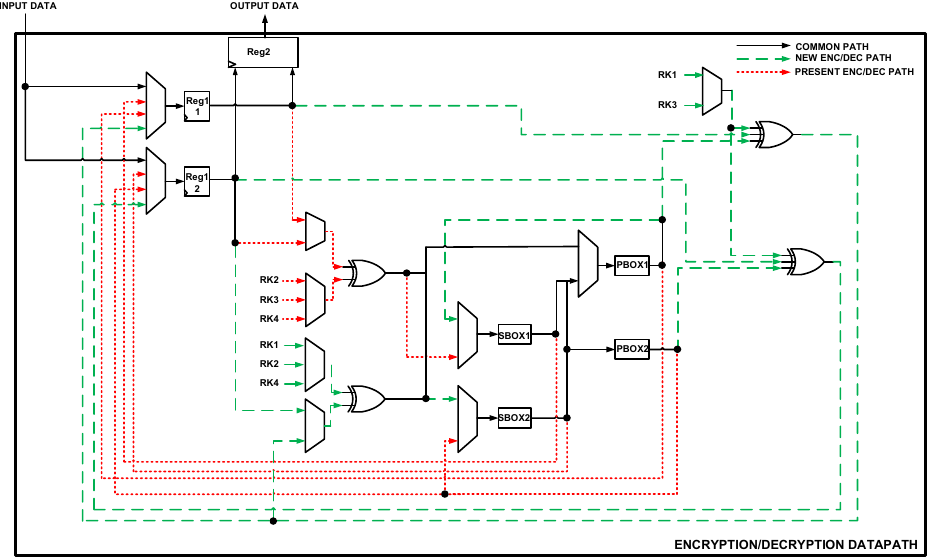
Figure 13. Proposed architecture for unifying two lightweight encryption/decryption protocols.